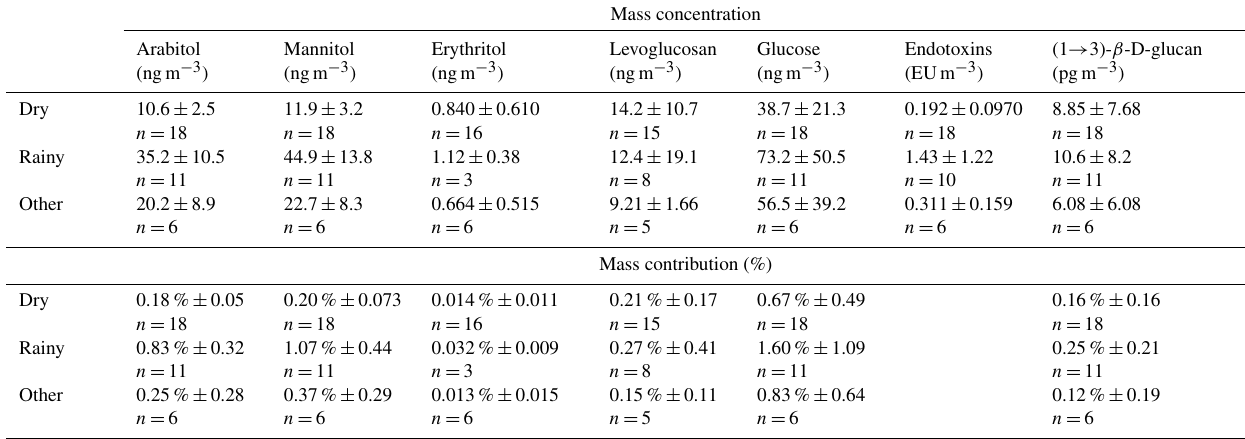
Table 1. Campaign-average concentrations of molecular tracers (top) and their respective mass contributions (bottom). Values are mean ± standard deviation; n shows number of samples used for averaging. Total particulate matter mass calculated from UV-APS num- ber concentration (m − 3 ), converted to mass over aerodynamic particle diameter range 0.5–15µm using 1.5gcm − 3 density.